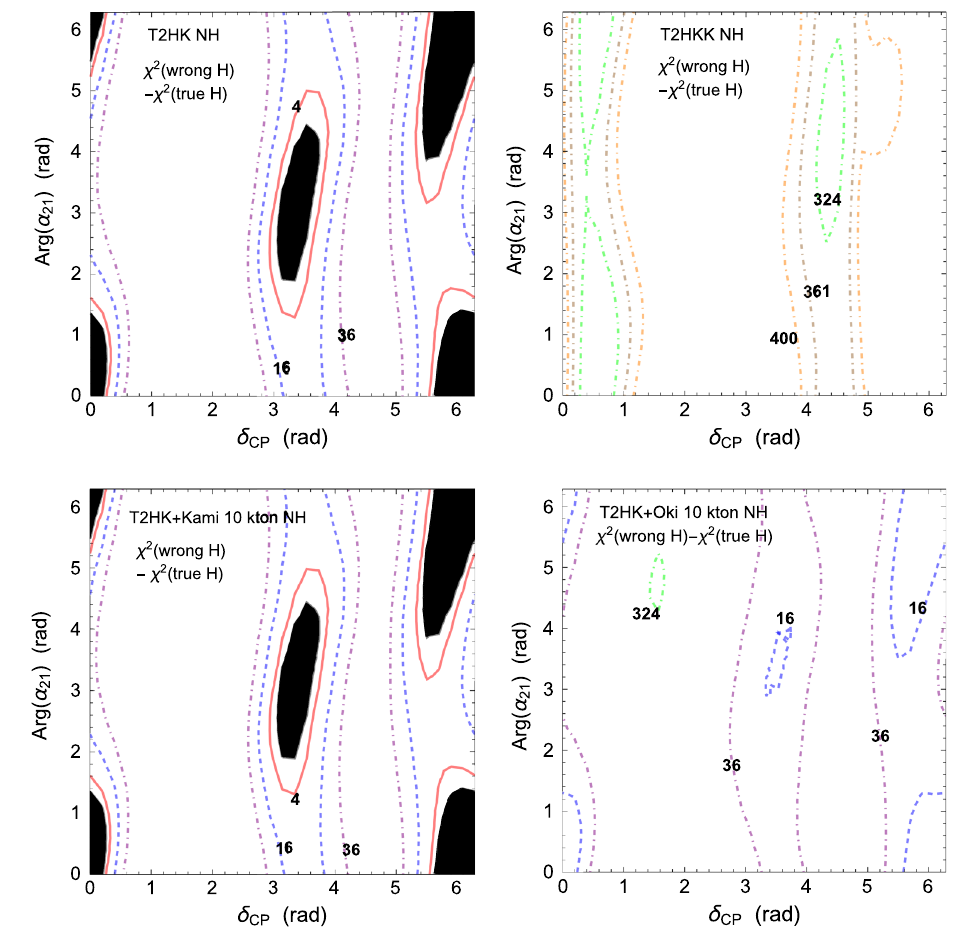
Fig. 2 The difference between the minima (with respect to δ CP only) of χ 2 ((cid:20)) for the wrong and true mass hierarchies, { min χ 2 ( wrong H ) − min χ 2 ( true H ) } . The benchmark with Eq. (26) is assumed, and the true mass hierarchy is normal. The upper-left, upper-right and lower- right subplots correspond to the T2HK, the T2HKK, and the plan of the T2HK plus a 10 kton water Cerenkov detector at Oki, respec- tively. For comparative study, we show in the lower-left a subplot